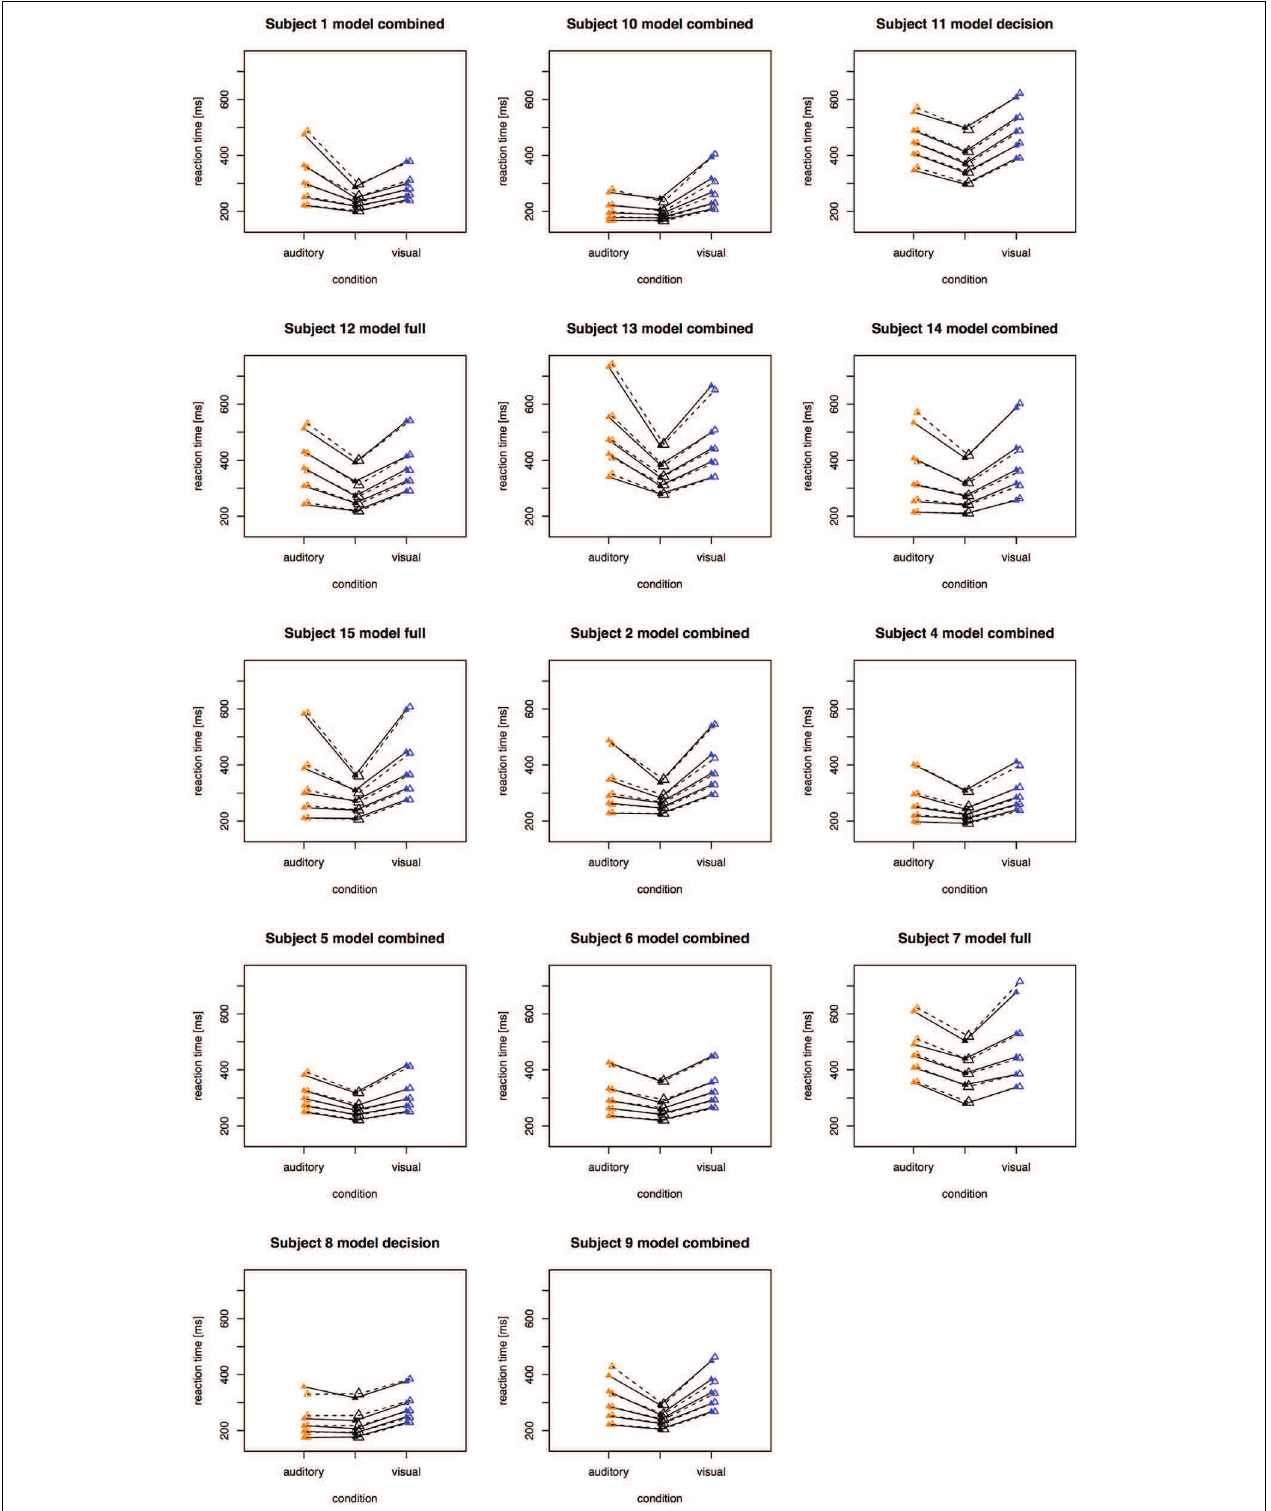
FIGURE 4 | Quantile reaction times. Quantile reaction times for single subjects in Experiment 1. The type of best fitting model is indicated in the each figure heading.